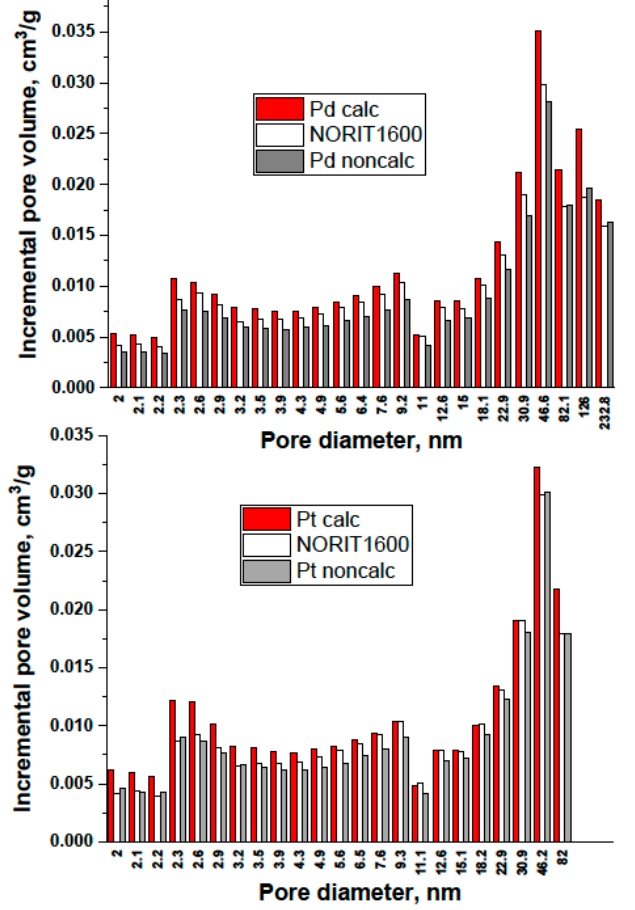
Figure 6. Pore size distribution of differently pretreated 2 wt % Pd 100 (acac)/Norit1600 (top) and 2 wt % Pt 100 (acac)/Norit1600 (bottom) catalysts. 2 wt % Pt 100 (acac)/Norit1600 ( bottom )